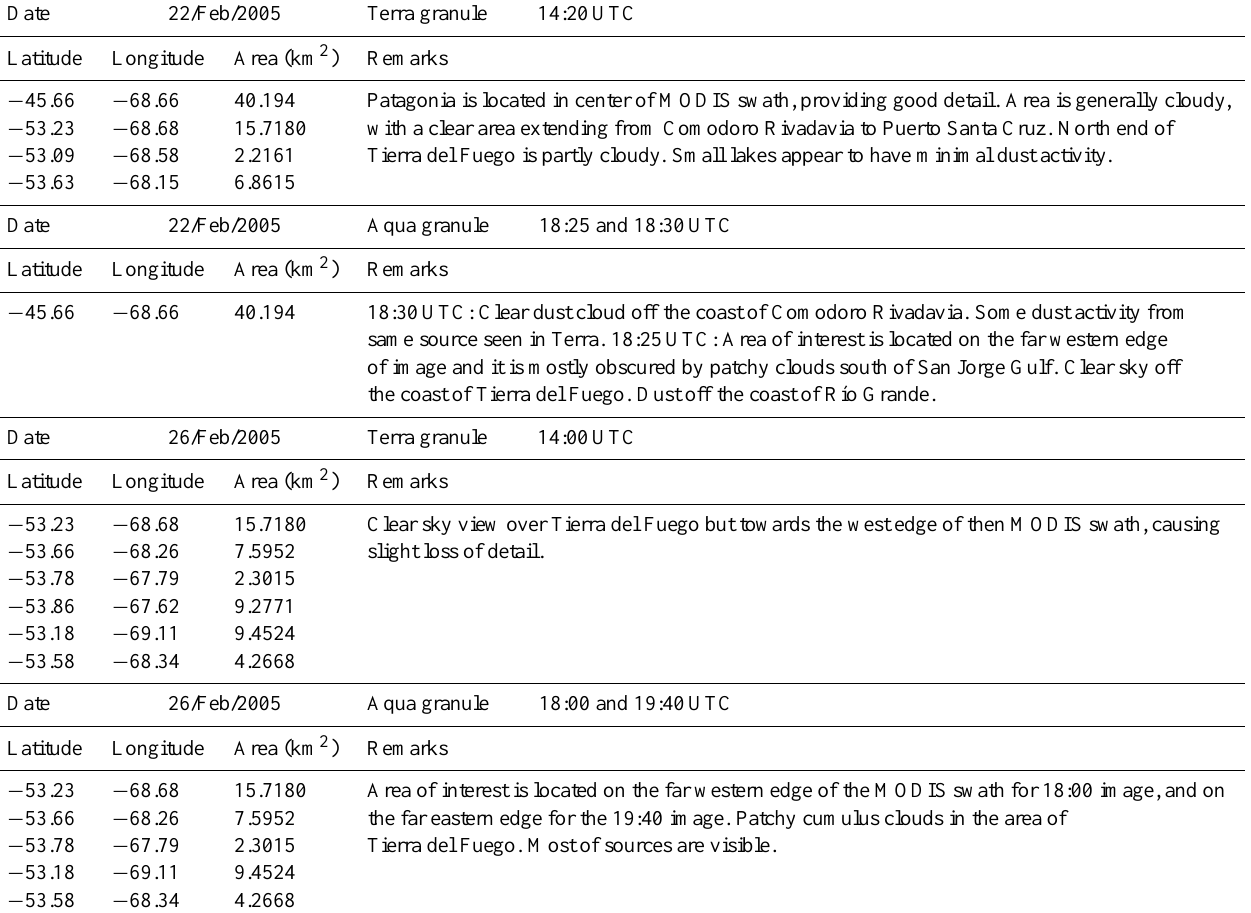
Table 1. Location and description of dust activity and sources as seen in MODIS visible images (observation time noted as “granules”). In all cases when it was not clear if dust is coming from the edge of the source, the estimated area of emission was to be the totality of the